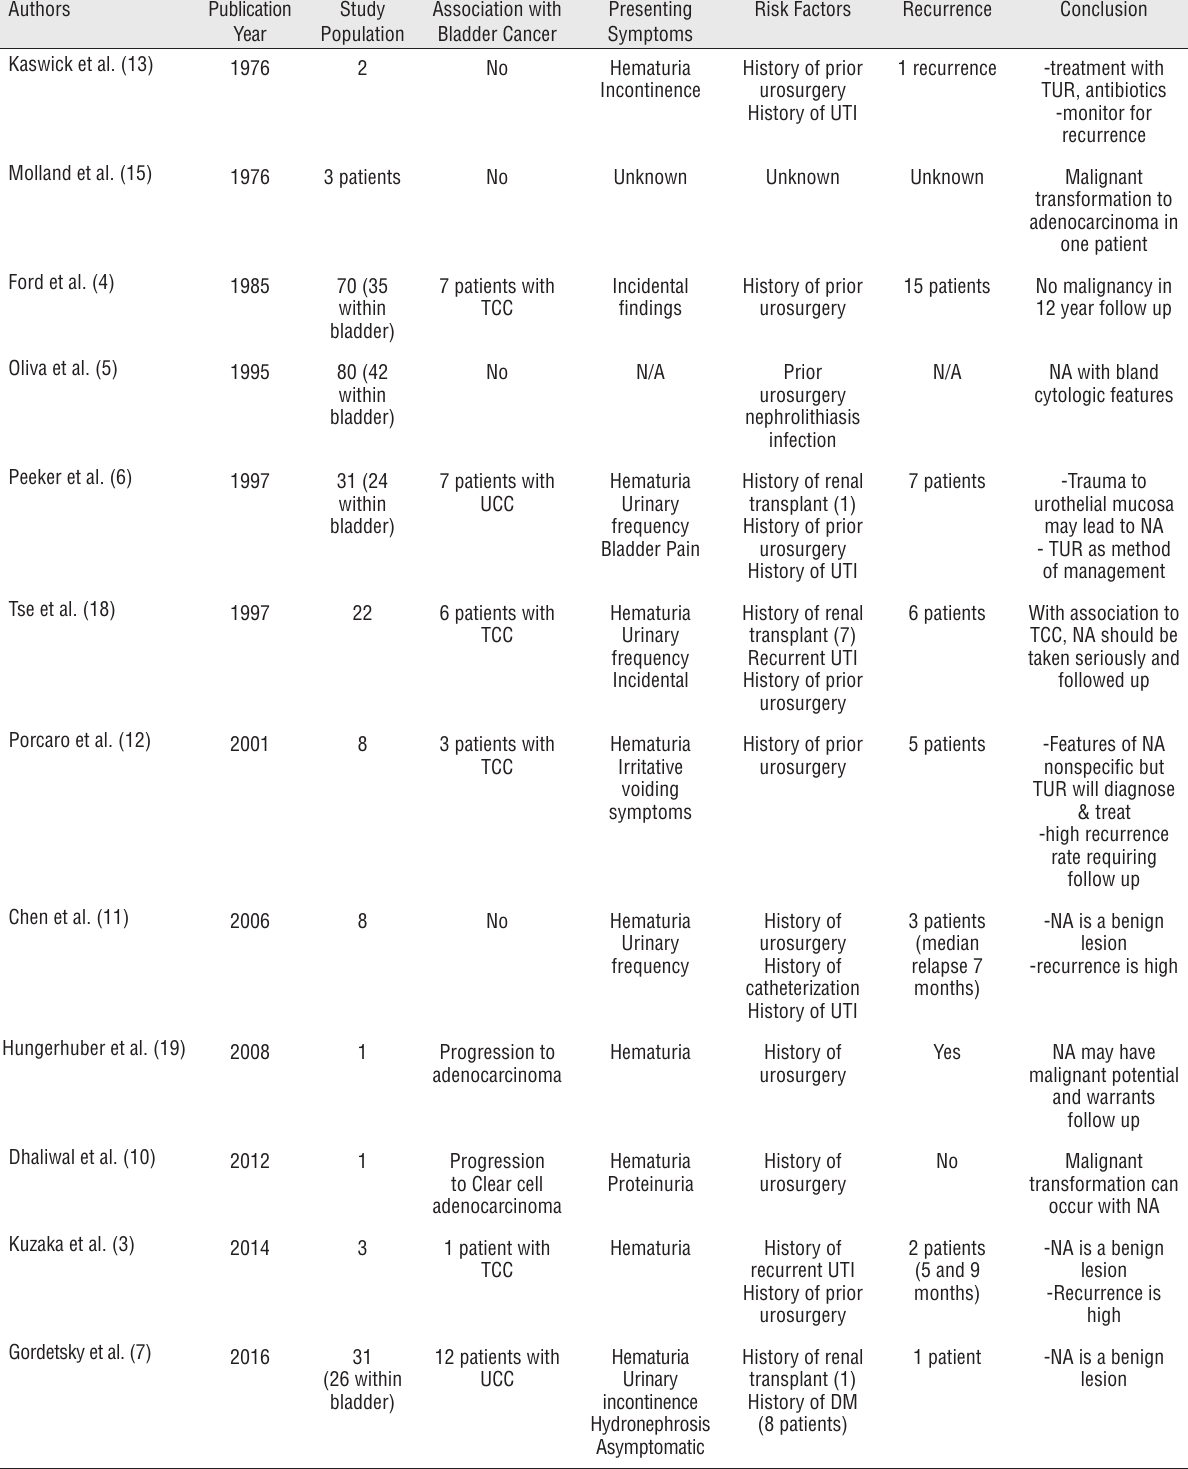
Table 3 - Summary of publications reviewing patients with nephrogenic adenoma of the